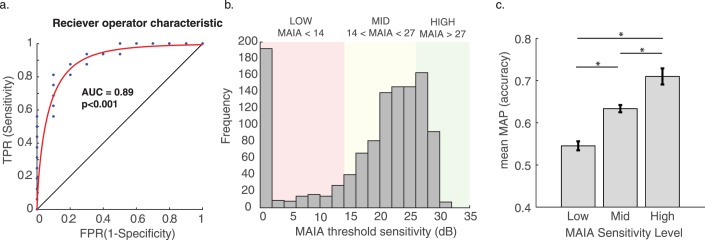
(a) ROC curve for classifying eyes labeled as pathological versus severely pathological (defined from MAIA microperimetry thresholds) using mean MAP accuracy measurements. (b) Distribution of MAIA sensitivity values across all retinal loci from all eyes in the study, where three discrete bins are defined to represent low, mid, and high level sensitivity. (c) Mean MAP accuracy and standard error across loci categorized as low, mid, and high based on MAIA sensitivity level. *P < 0.0001.